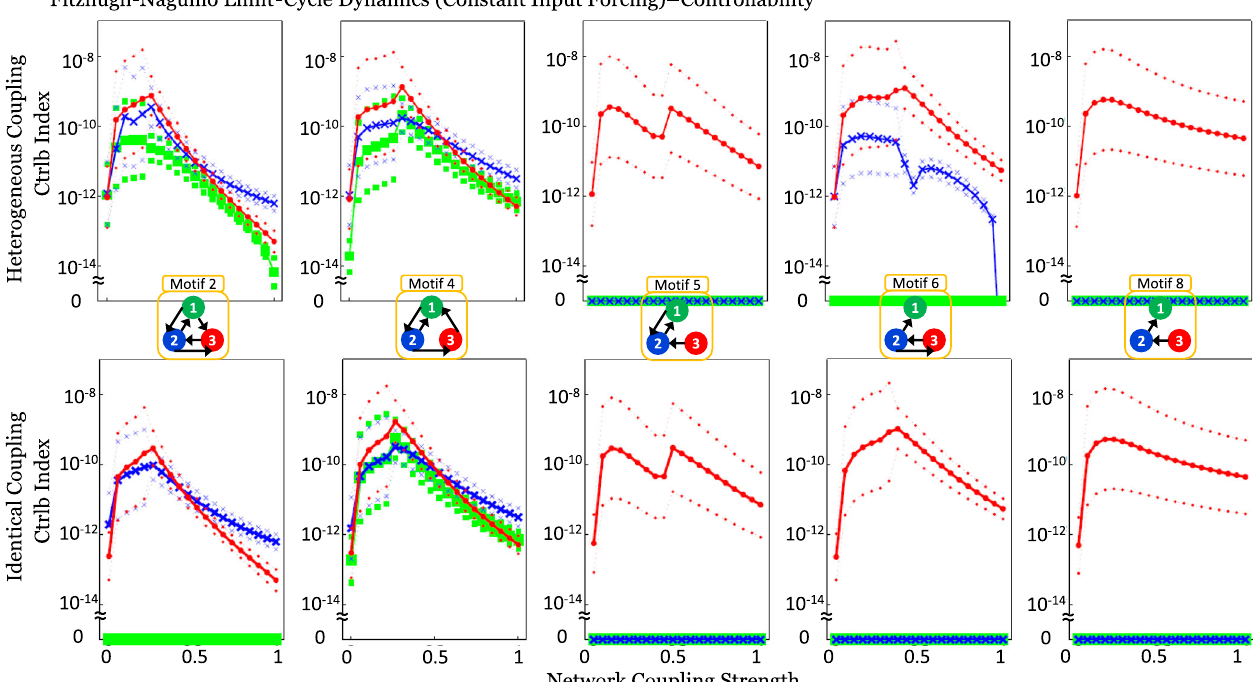
FIG. 6. Calculation of controllability indices for each of the FN network motifs with no underlying group symmetries for a limit-cycle dynamical regime with constant input current I ¼ − 0 . 45 ; all other details are the same as in Fig. 5. In particular, notice that local input- output symmetries cause zero controllability when controlling motif 2 from node 1 or motif 6 from node